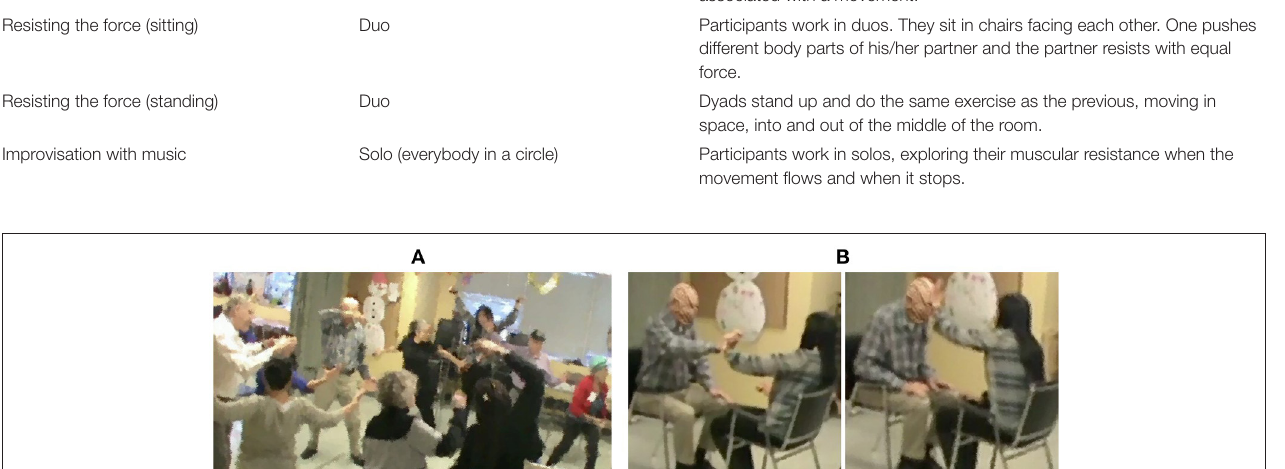
We computed the SSI over a 60-s sliding window to analyze the time-resolved interpersonal synchrony across the different activities of the movement session (Slovák et al.,